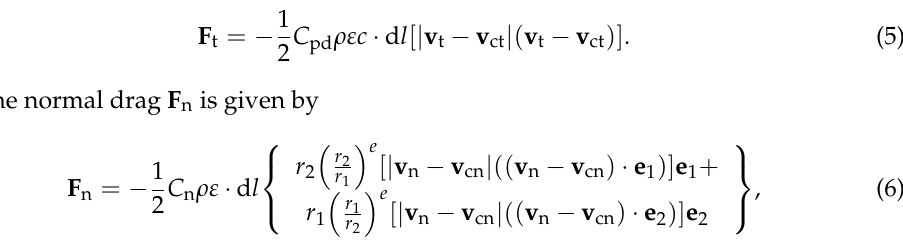
where v n is the velocity component of the center of an elliptical plate perpendicular to the longitudinal axis, and v cn is the current velocity component perpendicular to the longitudinal axis. The superscript coefficient e represents the eccentricity of the ellipse, (cid:113) − r 2 r 2 defined as e = / r 1 . In Equations (5) and (6), the immersion ratio of an elliptical 2 1 plate is denoted by ε , which is defined as the ratio of the immersed lateral surface area to the overall lateral surface area of the divided elliptical plate. In the numerical program, by further dividing the lateral surface of the elliptical plate into tiny quadrilaterals and by evaluating the z coordinate of the quadrilateral center (denoted by z q ), the immersion